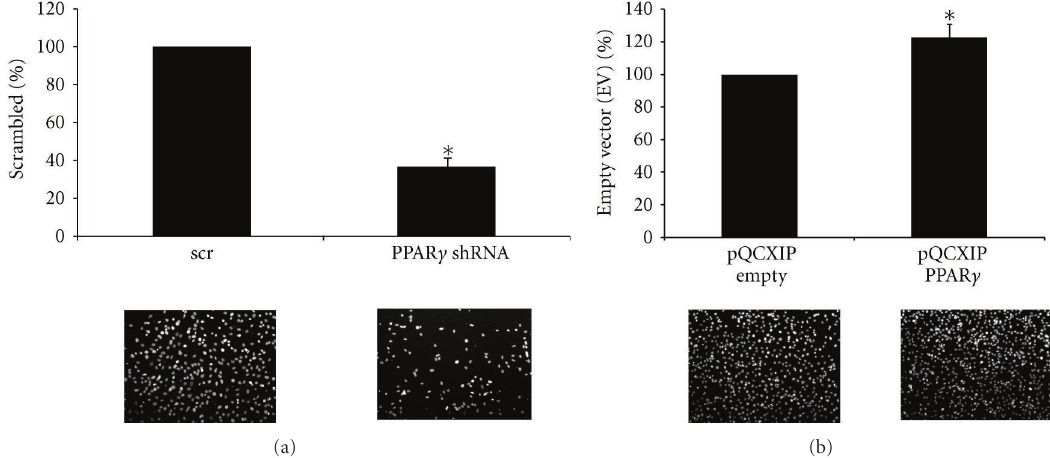
Figure 7: E ff ect of PPAR γ knockdown or overexpression on invasion. (a) HTh74 cells transduced with either scrambled (scr) or PPAR γ - specific shRNA were serum starved (0.1% FBS) for 24h. Cells (2 × 10 5 ) were transferred to a Boyden chamber and allowed to invade for 24 h toward medium containing 10% FBS. Cells on the bottom membrane were then stained with DAPI and counted using Metamorph Imaging Software (a representative DAPI-stained field is shown below the graph). Results shown are % inhibition of invading cells per field ± SEM ( ∗ , P = 0 . 0015, n = 4). (b) Empty vector or PPAR γ -overexpressing BCPAP cells were subjected to invasion assays as described in (a) ( ∗ , P = 0 . 013, n =